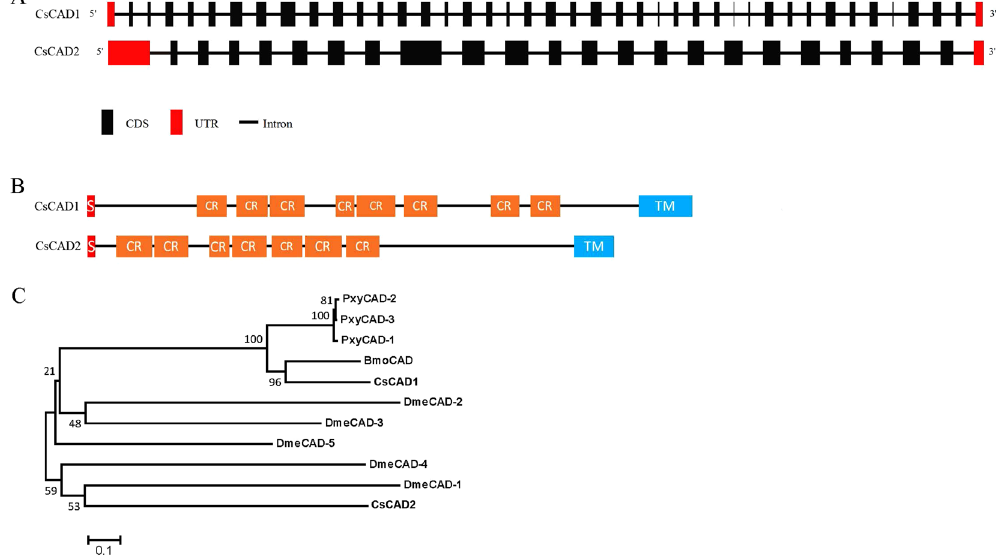
Figure 1. Structure ( A ), predicted domain structure ( B ) and phylogeny ( C ), of the Chilo suppressalis cadherin genes CsCAD1 and CsCAD2 . CR = characteristic cadherin repeat domains, S = signal peptide, TM = transmembrane domain. The phylogenetic tree of the relationships between CsCAD1 and CsCAD2 and eleven other Lepidopteran and Dipteran cadherin genes ( C ) was constructed using the neighbor-joining method in MEGA 6.0 with 1000 bootstrap replications. The GenBank accession numbers of the genes compared are AAM78590.1 and AGG36450.1 for C. suppressalis ( CsCAD1 and CsCAD2 ), NP_001036368.2, NP_650554.3, NP_731649.2, NP_788635.3 and NP_731930.2 for Drosophila melanogaster ( DmeCAD-1,